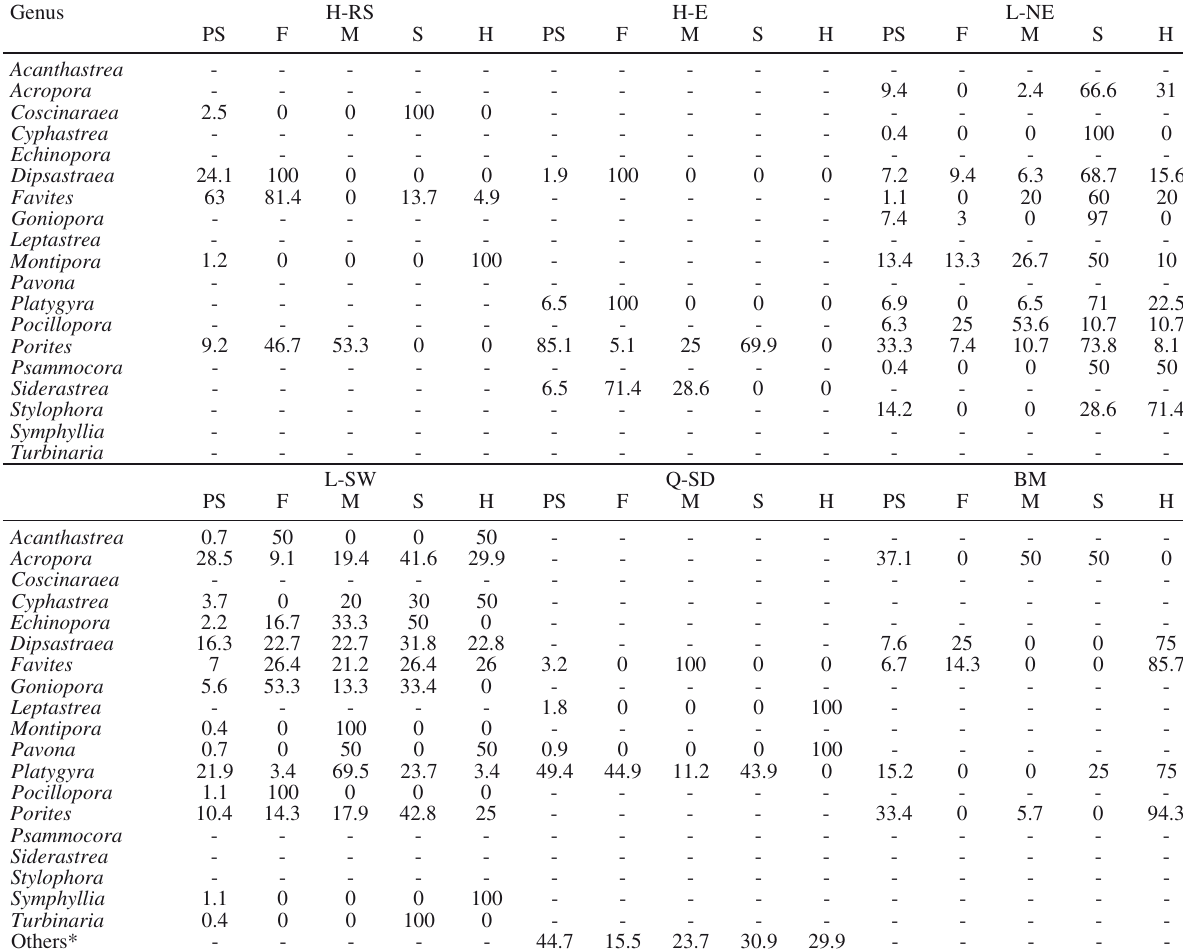
Table 2. – Coral genera recorded and their bleaching status (in percent) at each site. PS, percentage of each coral genus per site (number of colonies of each genus/number of total colonies counted). Bleaching categories considered: F, fully bleached; M, mostly bleached; S, slightly bleached; H, healthy. * It includes data on Porites , Dipsastraea and Cyphastrea at site Q-SD due to data input complications. Genus H-RS